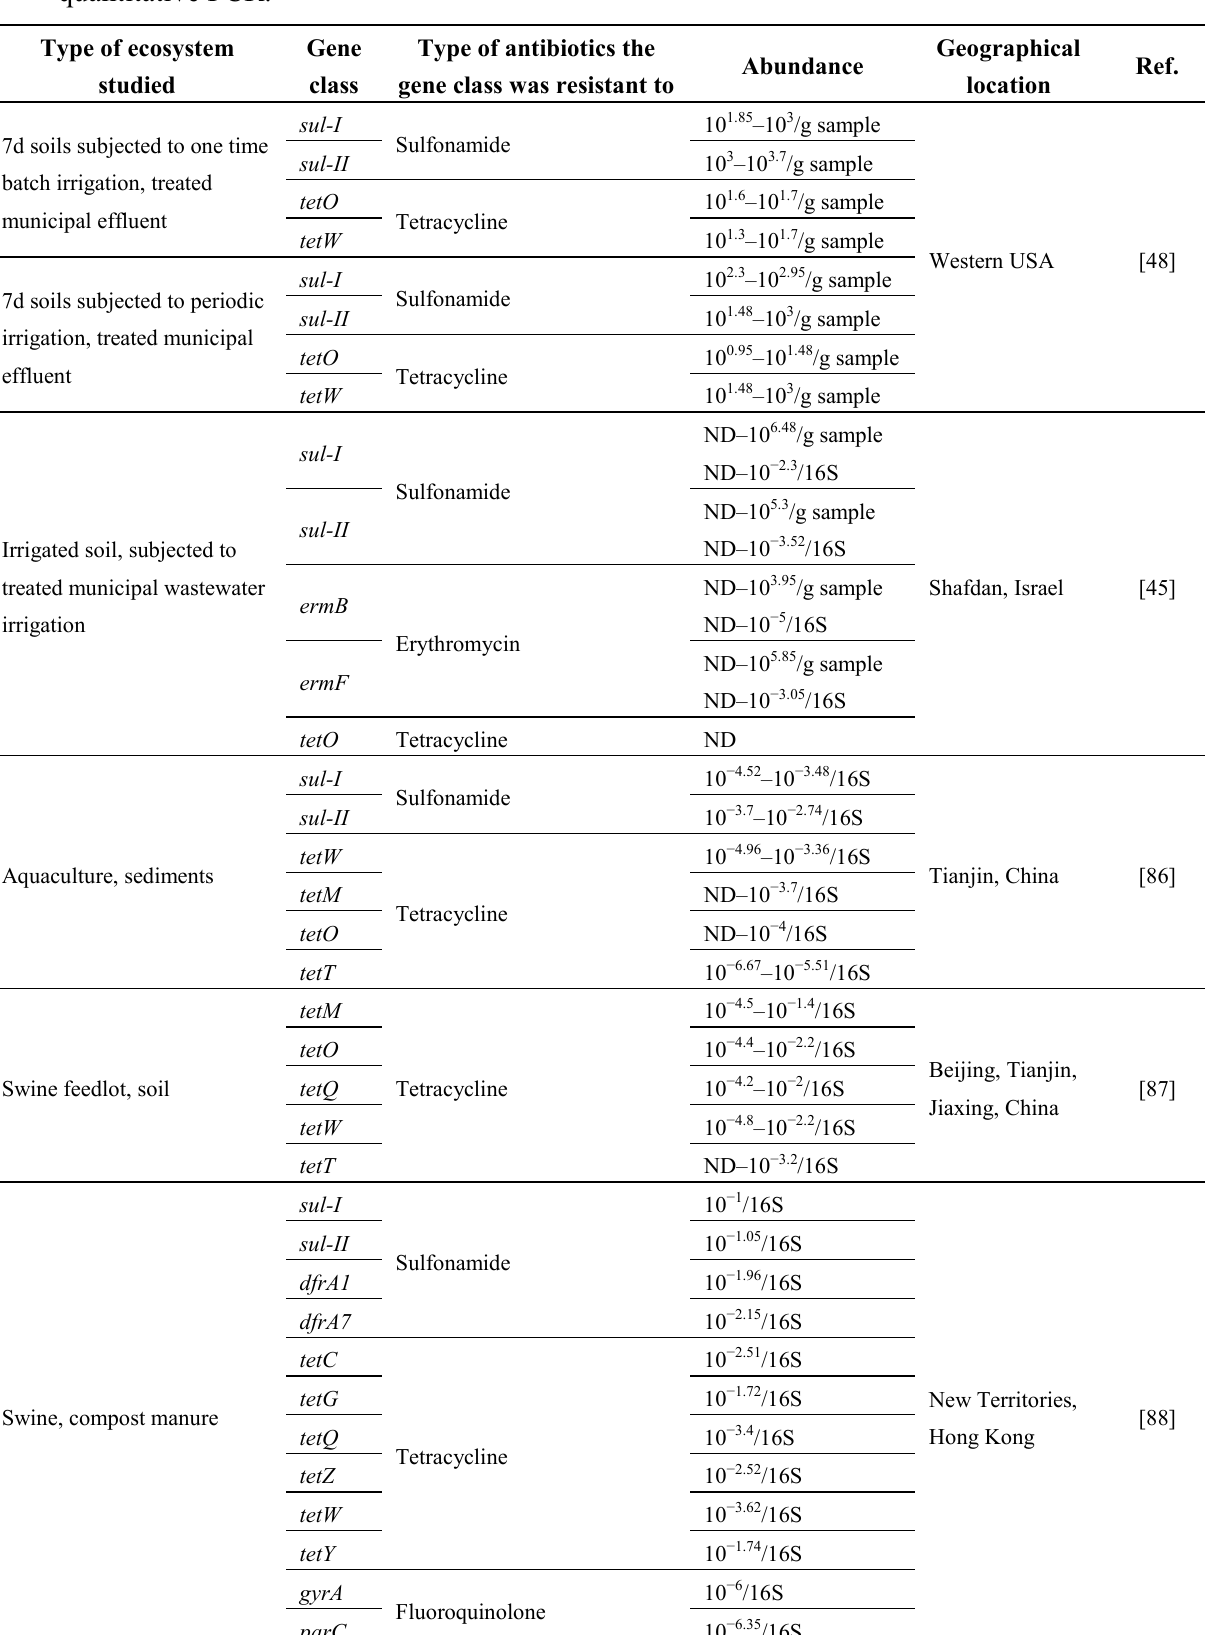
Table 4. Abundance of antibiotic resistance genes that was present in soils irrigated with treated municipal effluent or with livestock manure. Abundances were determined by quantitative